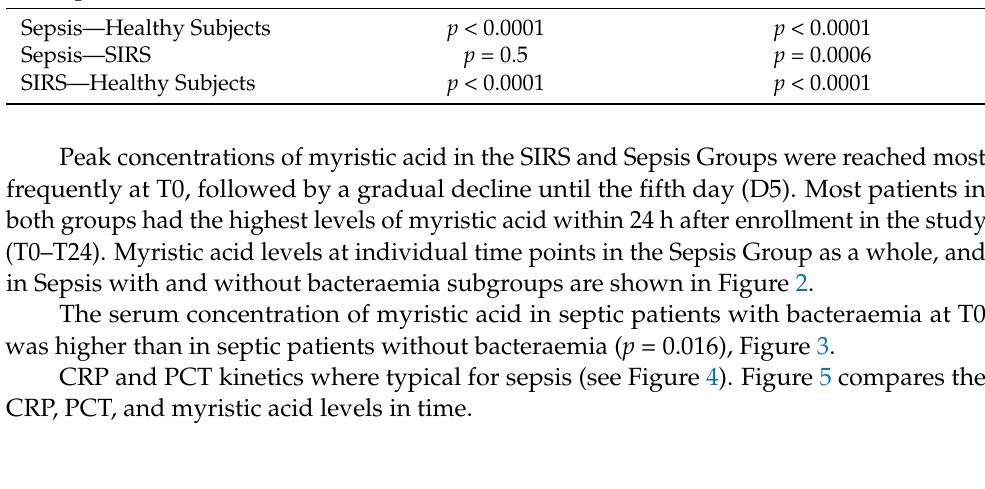
Table 5. Statistical significance of differences in myristic acid levels between the Sepsis, SIRS, and Healthy Control Groups.